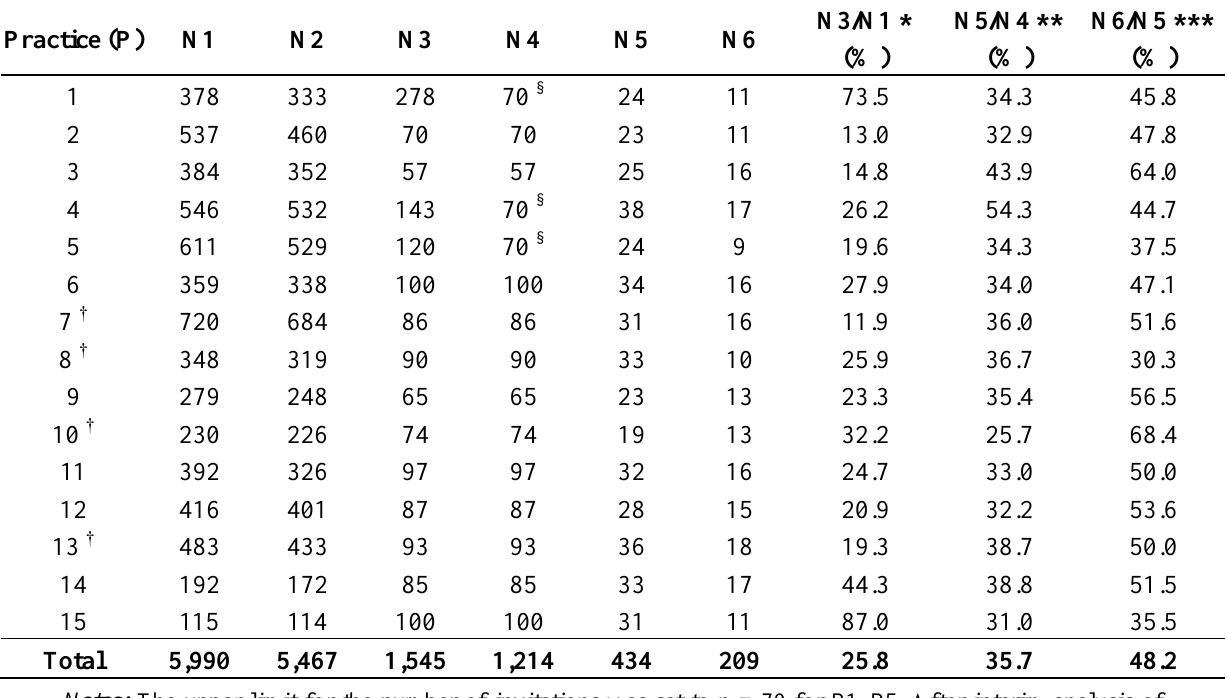
Table 2. Recruitment parameters N1–N6 and success rates broken down by